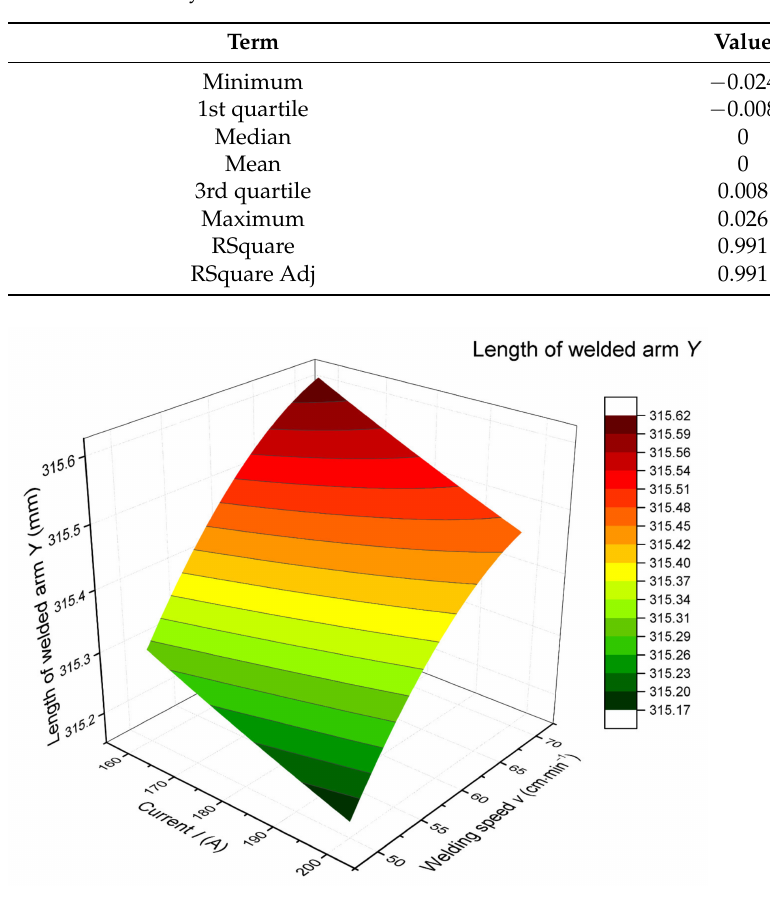
Figure 15. Dependence of the welded arm length on the current and the welding speed for the dimension of the stamping Z = 315.80 mm.